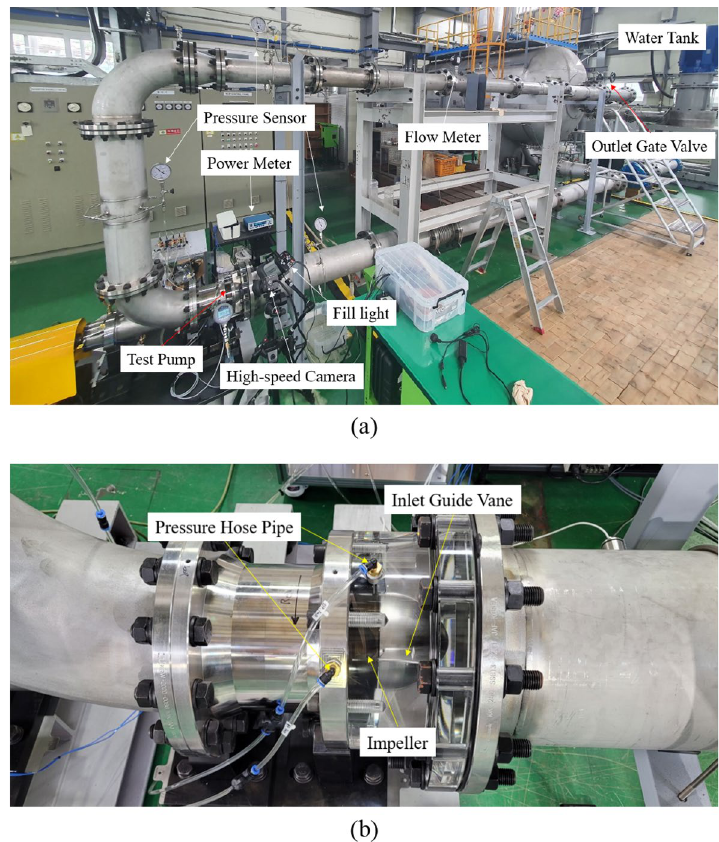
Figure 3. Experimental test of the axial-flow pump. ( a ) Test system, ( b ) Test pump.